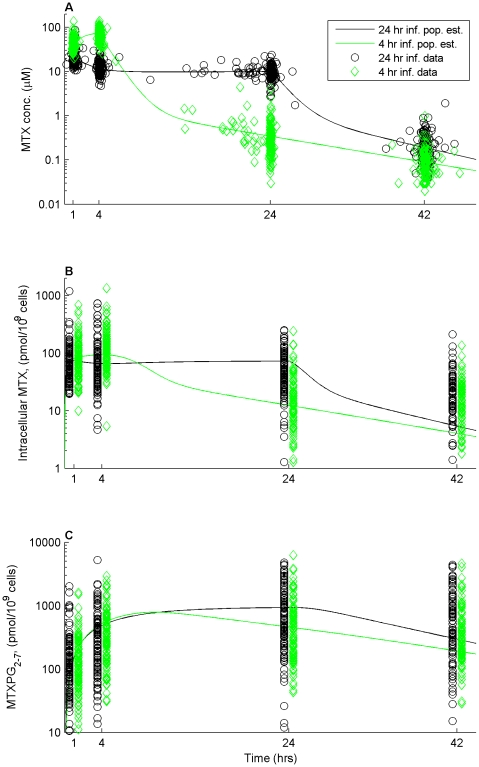
MTX and MTXPG concentration vs time plots.(A) Plasma MTX concentration (µM) vs time (hrs). (B) Intracellular MTX (MTXPG1) concentration in peripheral blood cells (pmol/109 cells) vs time (hrs). (C) Intracellular MTXPG2-7 concentration in peripheral blood cells (pmol/109 cells) vs time (hrs). Black lines and circles represent the model fit and data given a 24 hour infusion and green lines and dimonds represent the model fit and data given a 4 hour infusion. We plotted the MTXPG concentrations at fixed time points around each sampling time to prevent the samples from the two different infusion groups from overlapping.